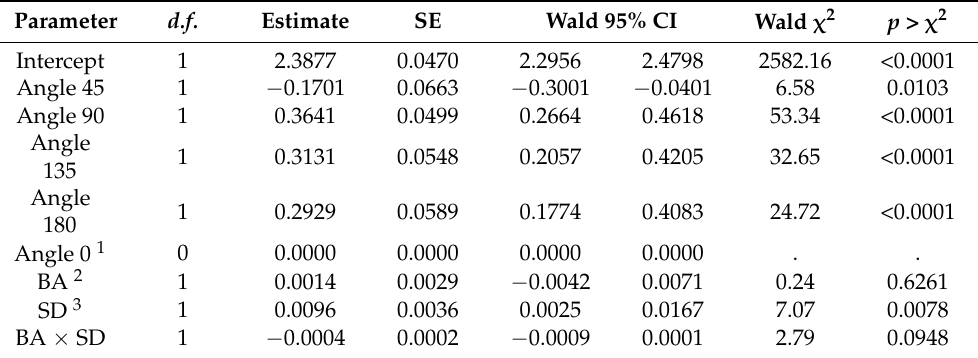
Table 2. Parameter estimates for generalized linear model results of synthetic bat echolocation playback response within an anechoic chamber to detector angle ( ◦ ) and simulated clutter variation represented by basal area (m 2 /ha) and stem density (stem count) for maximum frequency (Fmax), Blacksburg, VA, USA, 2016. Detectors recorded in full spectrum (see text for